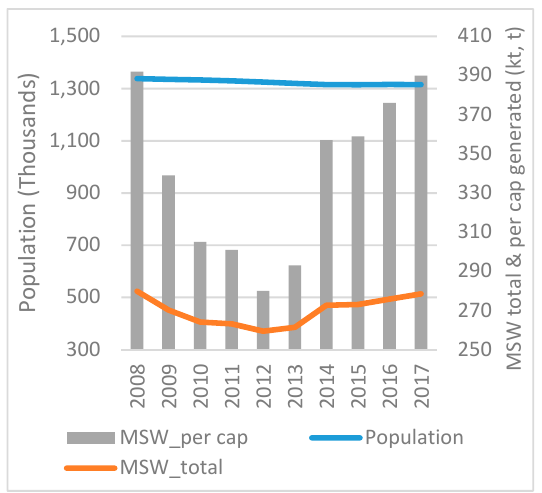
Figure 11. Population and MSW production in Estonia 2008–2017 (European Statistics 2019a, 2019c).